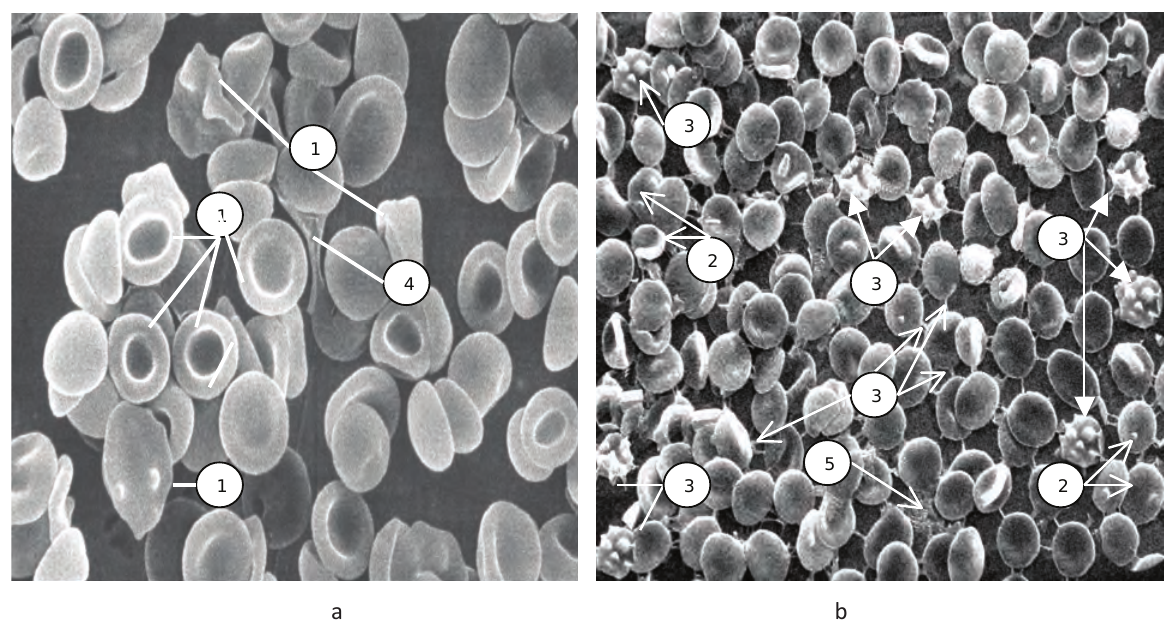
Fig. 3. Structural reconstruction of periphery blood erythrocytes in 1 st (a) and 2 (b) groups’ volleyball players with hyper-kinetic hemo-dynamic type after single maximal physical load. Legend: 1 – normal forms of erythrocytes; 2 - reversibly changed forms of erythrocytes; 3 – irreversibly changed forms of erythrocytes. 4 – “adhesion threads”;